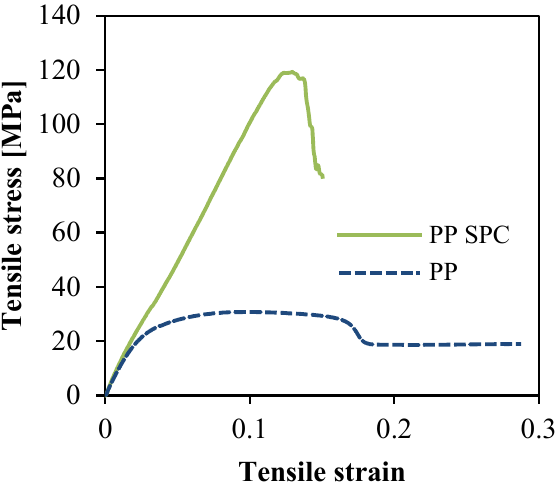
Figure 8. Tensile stress–strain behaviors of the different tensile samples of PP SPC and pure PP.